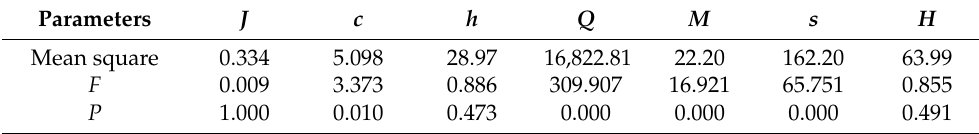
Table 4. ANOVA results of the influence of illuminance change on the colour appearance properties of serpentinite.